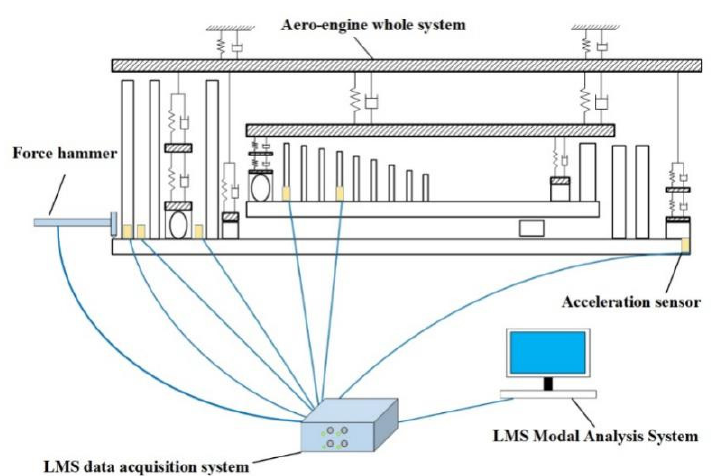
Figure 4. Schematic diagram of dual-rotor modal test for aero-engine whole system.